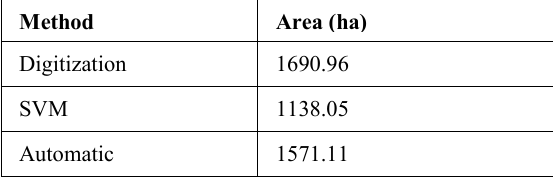
Table 3. Area statistics of green space from three different